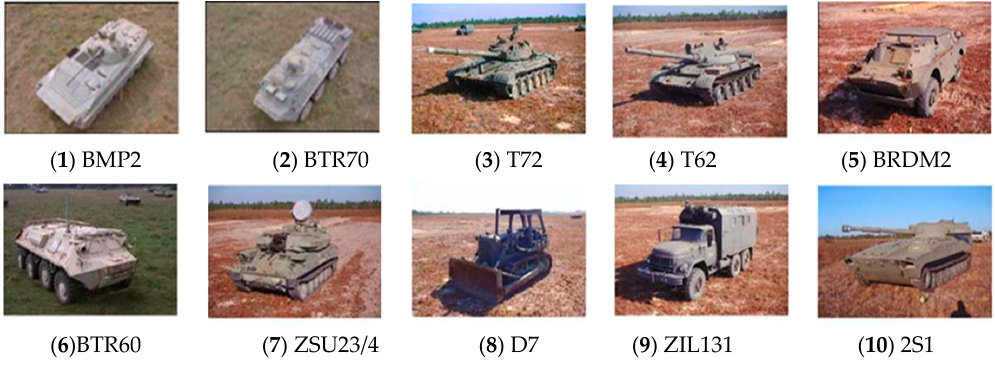
Figure 5. Optical images of the ten military targets.